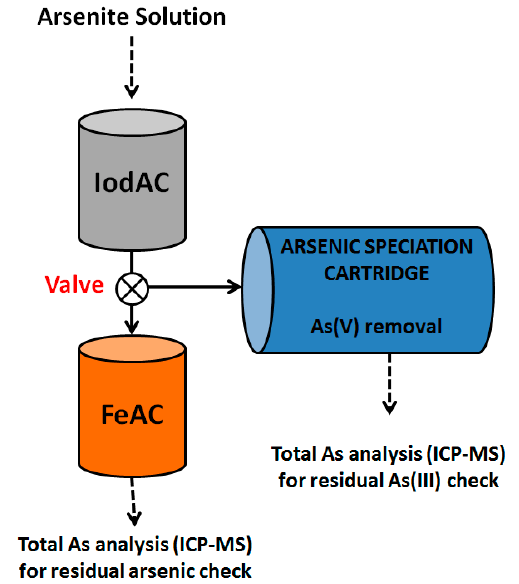
Figure 6. Scheme of the combined (oxidation and arsenic adsorption) column experiment.